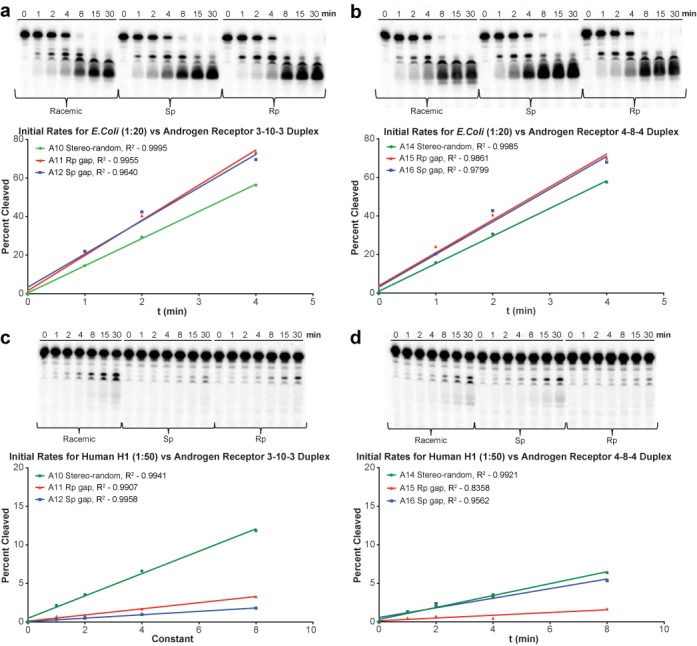
RNase H1 cleavage of P-32 labeled mRNA with AR ASO/RNA duplexes. For each set of lanes, the incubation time was 0, 1, 2, 4, 8, 15 and 30 min. (a) E. coli RNase H1 and 10-base gap ASO/RNA duplex; (b) E. coli RNase H1 and 8-base gap ASO/RNA duplex; (c) human RNase H1 and 10-base gap ASO/RNA duplex; (d) human RNase H1 and 8-base gap ASO/RNA duplex.